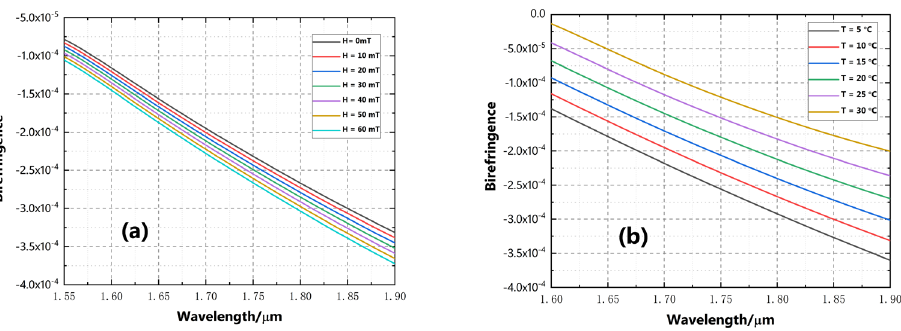
Figure 4. Effects of magnetic field ( a ) and temperature ( b ) on the phase birefringence B, D = 1.92 µ m, d = 1.2 µ m, Λ = 2.0 µ m, and t ITO = 45